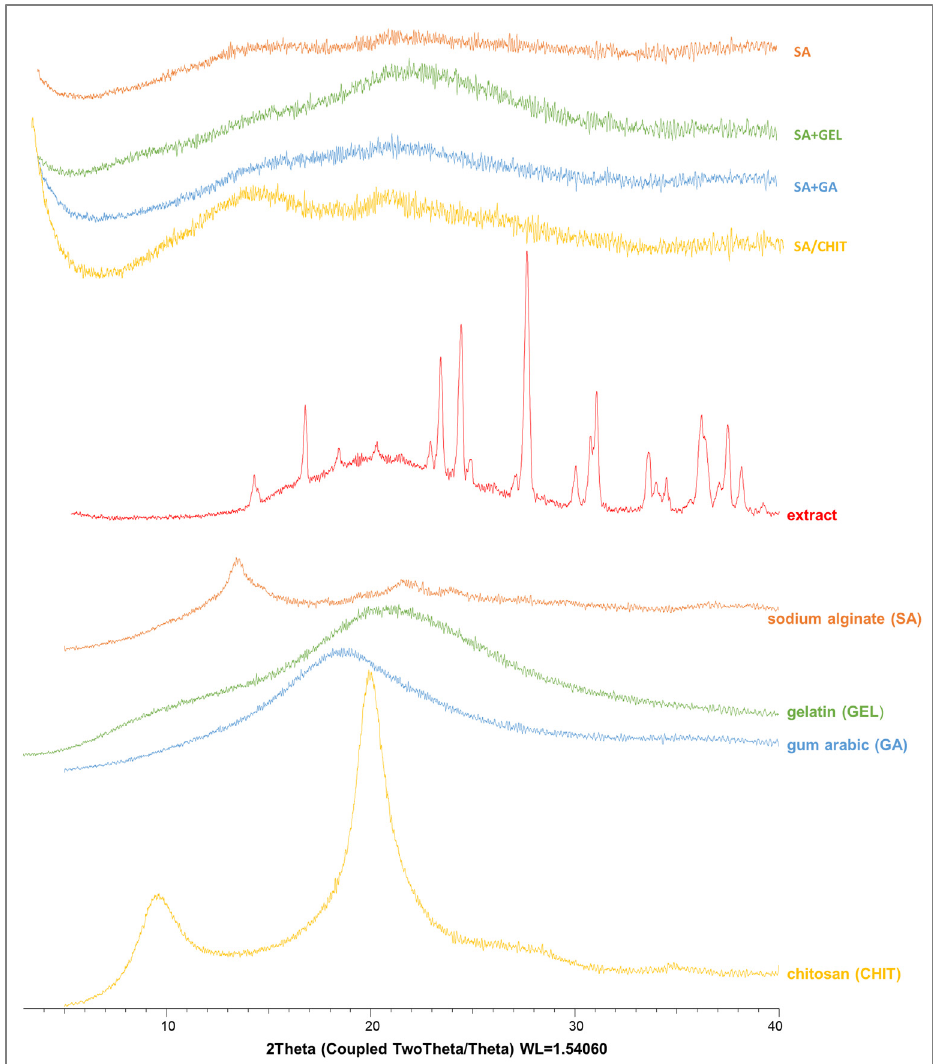
Figure 4. X-ray powder diffractograms of grape pomace extracts, pure coatings (sodium alginate, SA; chitosan, CHIT; gum arabic, GA; and gelatin, GEL), and freeze-dried microbeads containing phenol-rich grape pomace extract prepared using various coatings (SA; combination SA/CHIT; SA + GA; and SA + GEL).